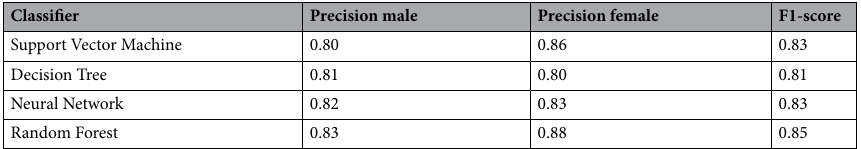
Table 2. Comparison of the four used classifiers in terms of precision per gender and F1-score. Number of examples is denoted by m = 1702. Used features: {q1, q2, ..., q7, q8_5} , test size 20%. Note that the feature labels qx are further explained in Table